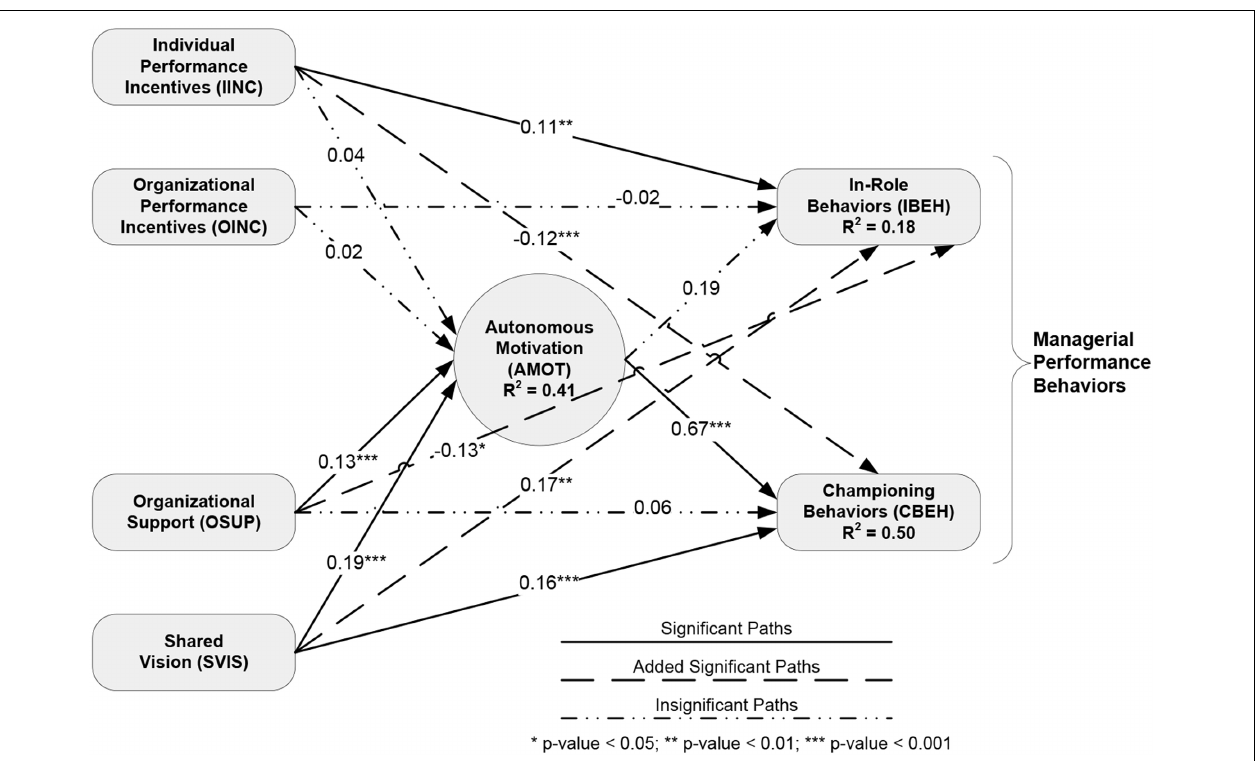
FIGURE 3 | Path diagram.